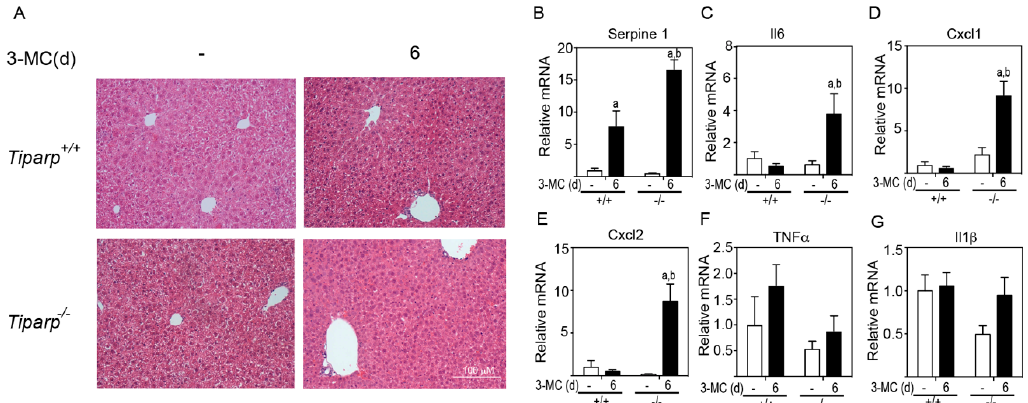
Figure 5. 3MC induces increased inflammation and inflammatory cytokine levels in Tiparp − / − compared with WT mice. ( A ) Hematoxylin & Eosin (H&E) staining of the liver lobe at day 6 after corn oil or 3MC treatment. 100 × magnification. Scale bar represents 100 µ m. Gene expression levels of Serpine 1 (PAI-1) ( B ), Il6 ( C ), Cxcl1 ( D ), Cxcl2 ( E ), Tnf α ( F ), and IL1 β ( G ). Data represent the mean ± SEM; n = 3 for all genes. a p < 0.05 two-way ANOVA comparison between genotype-matched corn oil- and 3MC-treated mice and b p < 0.05 two-way ANOVA comparison between treatment-matched WT and Tiparp − / − mice followed by a Tukey’s post hoc test.